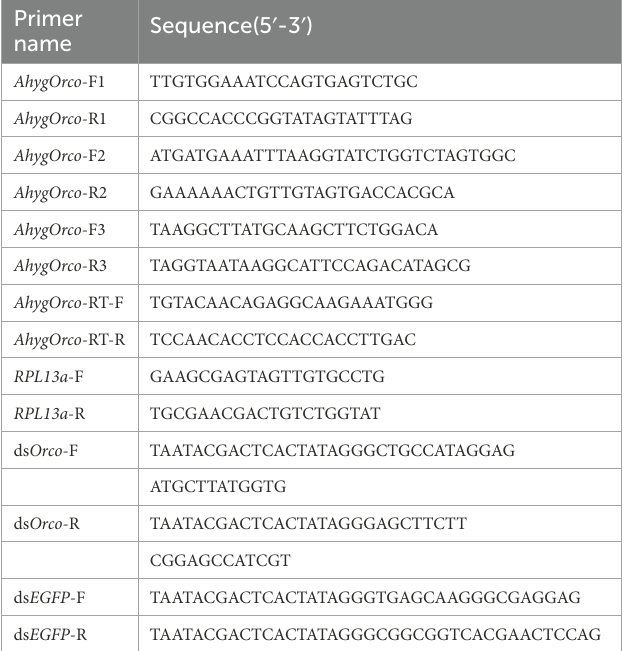
TABLE 1 List of the designed primers for PCR for AhygOrco cloning, qRT-PCR and dsRNA